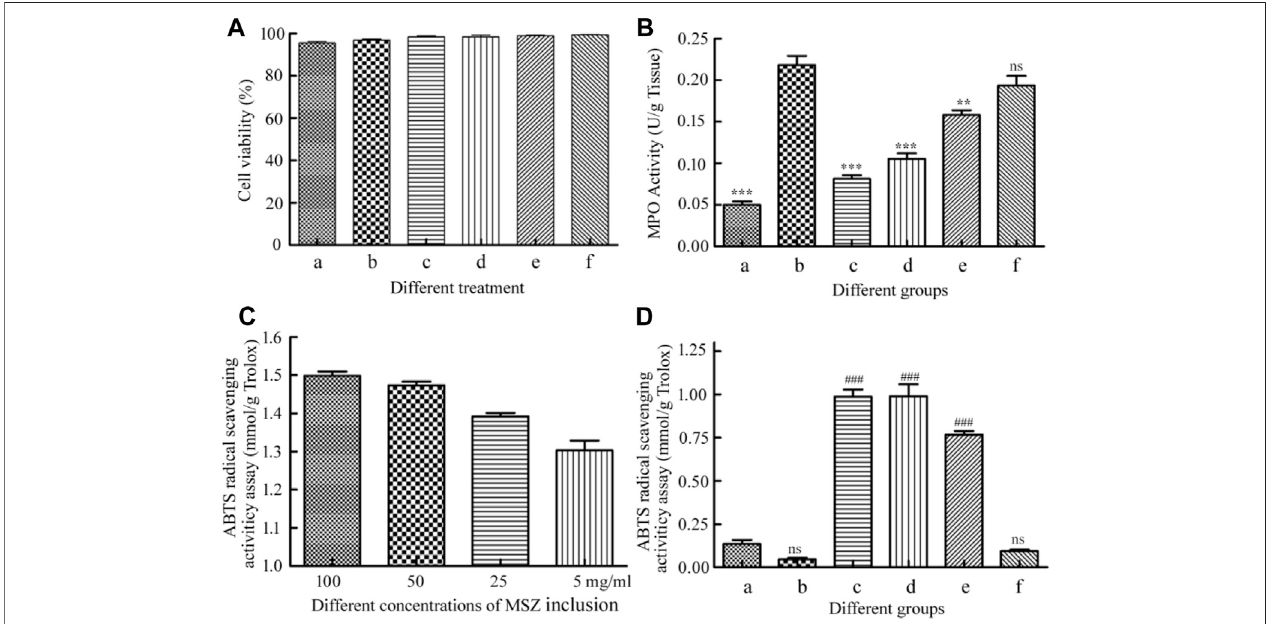
FIGURE 6| (A) The cytotoxicity of the HP- β -CD/MSZ inclusion complex, the blank hydrogel, and the drug-loaded hydrogel bythe CCK-8 assay. (B) Colonic MPO activities. (C) ABTSradicalcationscavengingactivityoftheHP- β -CD/MSZinclusioncomplexwithdifferentconcentrations. (D) ABTSradicalcationscavengingactivityof mice serum expressed as trolox equivalents. In (B , D) , a, normal; b, DSS; c, the positive drug group; d, the MSZ-loaded hydrogel group, e, the HP- β -CD/MSZ inclusion complexgroup;andf,theblankhydrogelgroup.Thedatain (A , C) arethemean ± SDofthreeindependentexperiments( n (cid:2) 3).Thedatain (B , D) arethemean ± SD of six data ( n (cid:2) 6); compare to the DSS group, ** p < 0.01, *** p < 0.001; compared to normal group, ### p < 0.001; ns, no signi fi